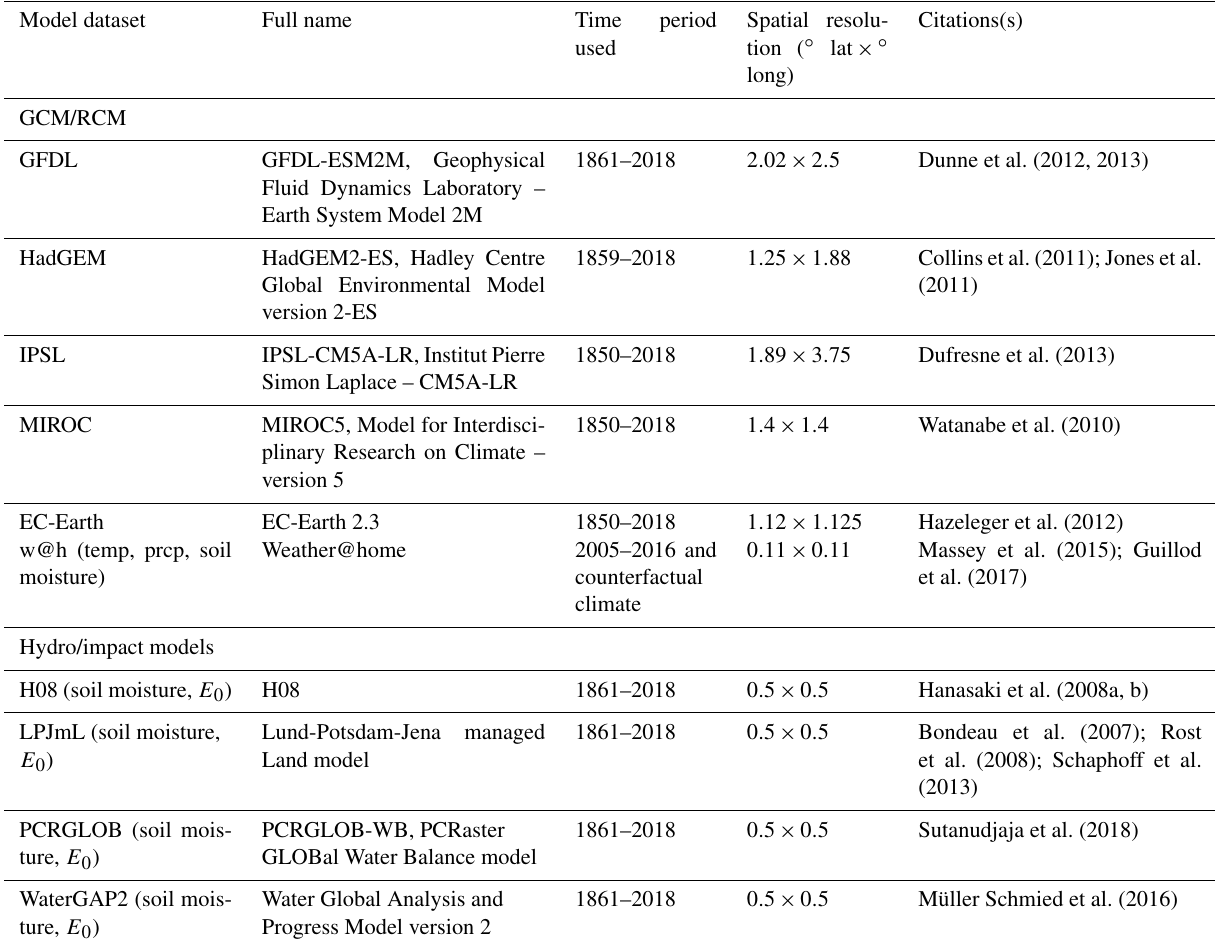
Table 3. Model data used in this study. Model